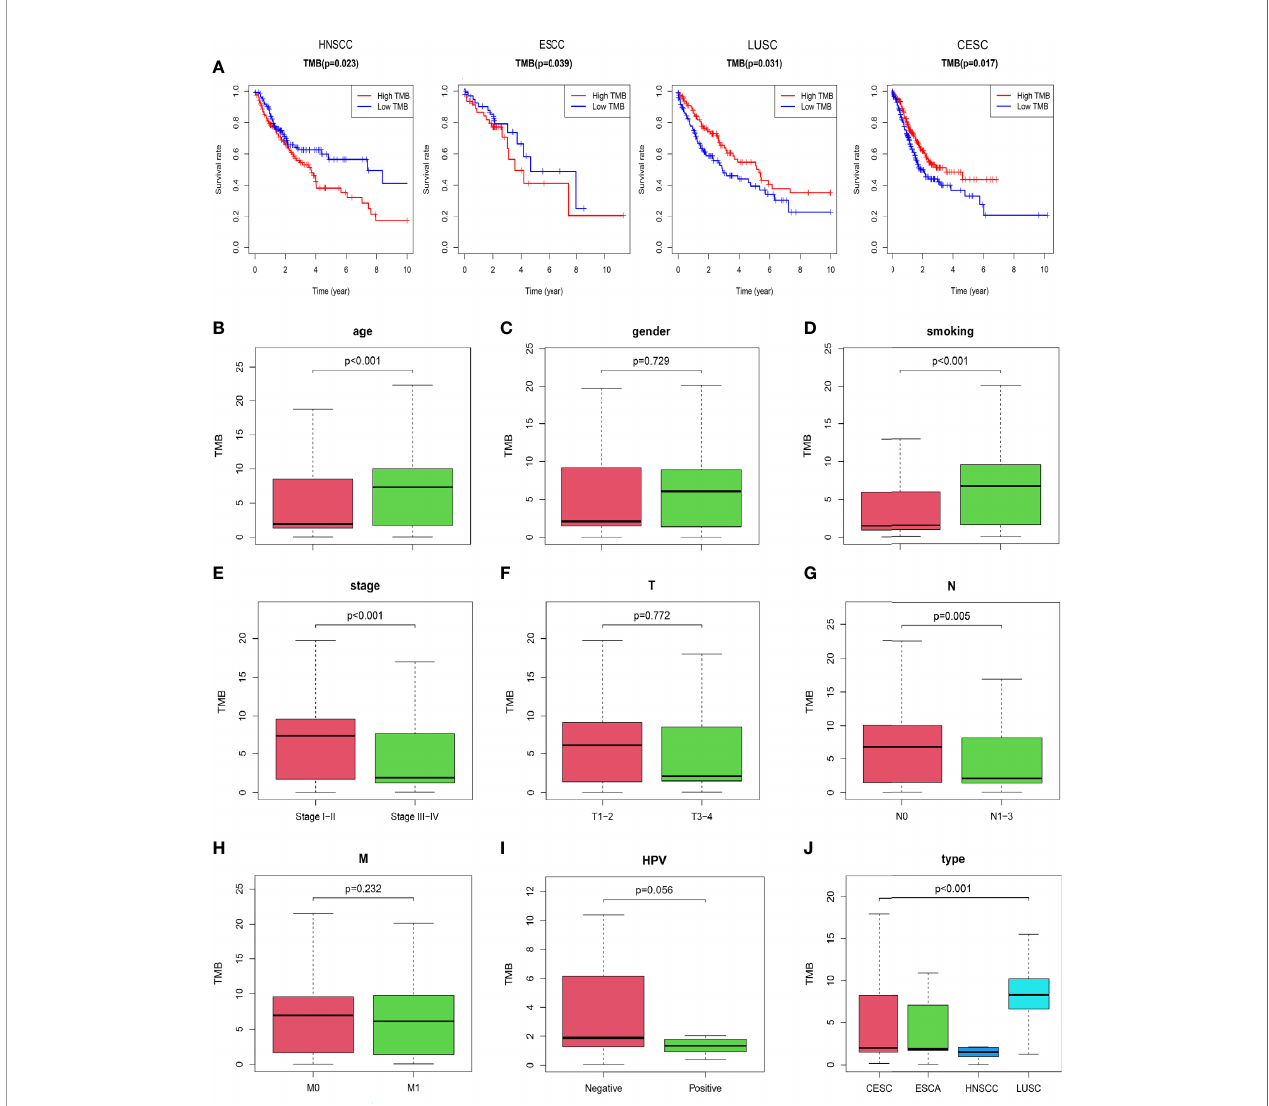
FIGURE 2 | Prognosis of TMB and association with clinical characteristics (A) Patients with low TMB had better prognosis In HNSCC and ESCC. Patients with high TMB had better prognosis in LUSC and CESC. (B, D, E, G) Patients with older age, smoking history, lower pathological stage, and no lymphatic invasion had higher TMB. (C, F, H) No signi fi cant correlations were observed between TMB and gender, AJCC-T stage, and AJCC-M stage. (I) There was no signi fi cant correlation between TMB and HPV infection. (J) TMB was signi fi cantly different among the four types of SCCs, with the highest TMB in